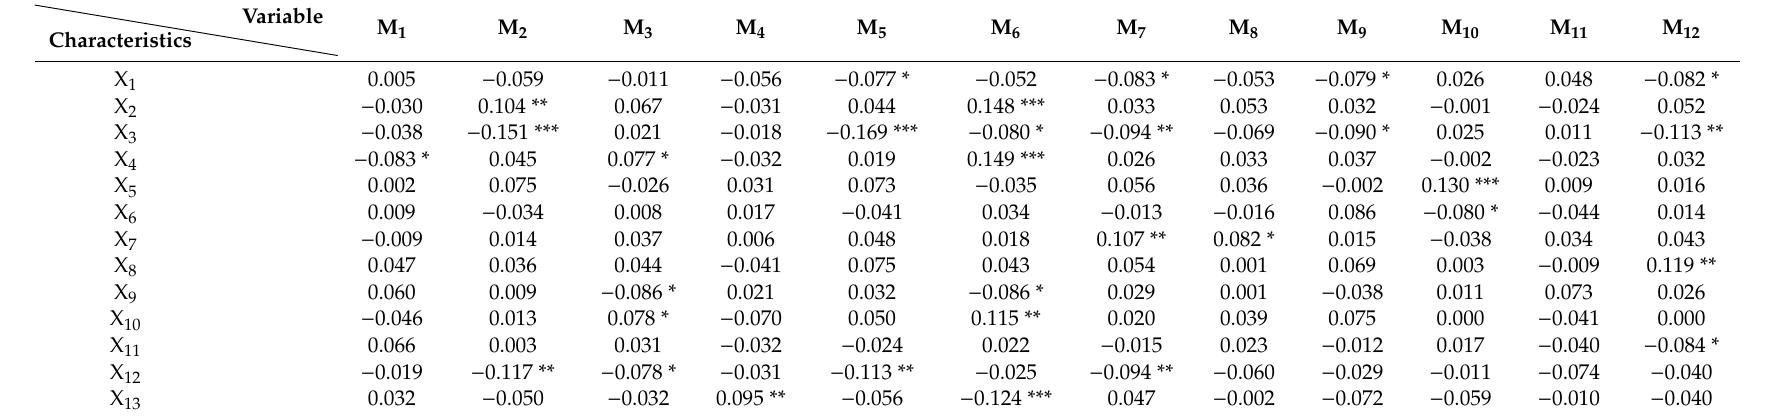
Table 4. Pearson’s relevance test between the spatial image perception of citizens and their individual